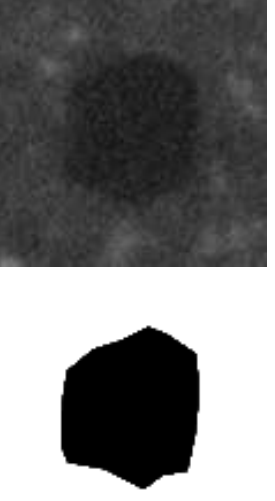
Fig. 13: U-Net: an example for of reinforcemen learning to capture the feature details of the diamond marked with a red circle in Fig. 12 (a).